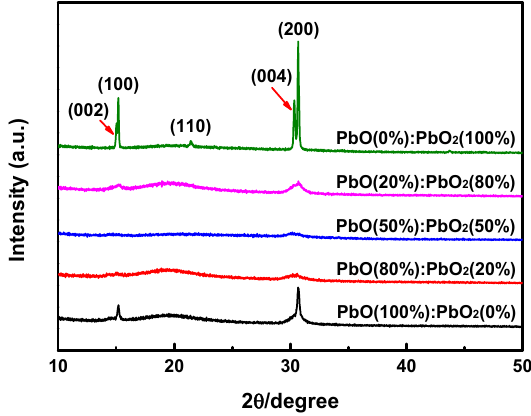
Figure 2. X-ray diffraction (XRD) patterns of CsPbBr 3 -QD films with different PbO/recycled PbO 2 ratios.